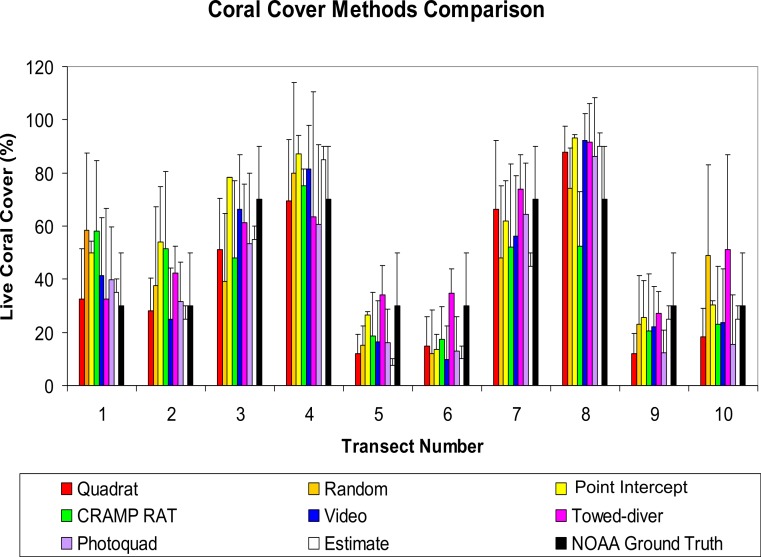
Error bars for the first 7 methods (rainbow colors) are Standard Deviations.Error bars for the last two methods (white for Estimate and black for NOAA Ground Truth) represent estimated range.